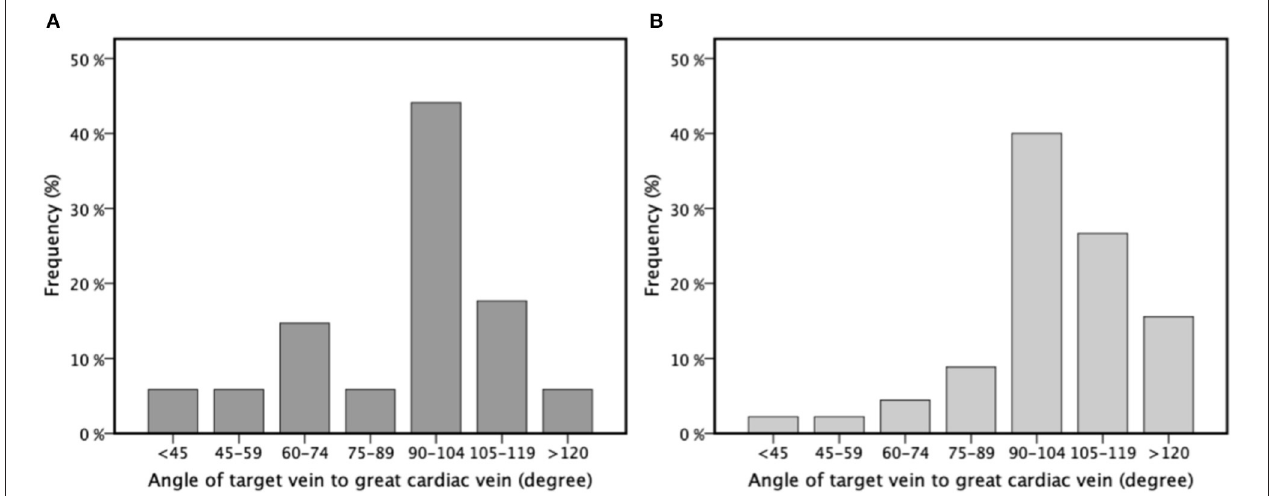
FIGURE 2 | The angle of target vein to the great cardiac vein for bipolar active fixation left ventricular lead (A) and quadripolar passive fixation left ventricular lead (B) divided into different categories for better visualization presented in percentages of frequency (%) by a bar chart.